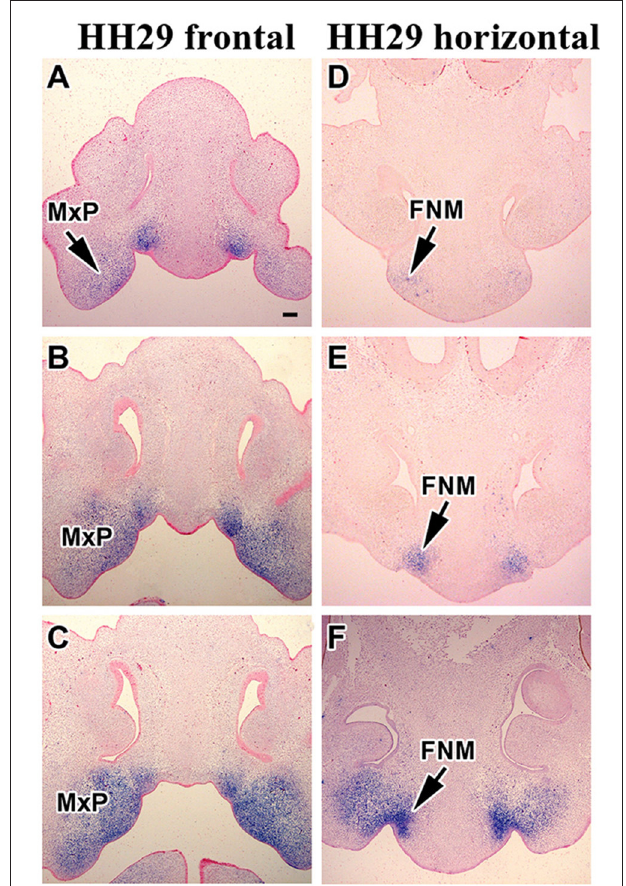
FIGURE 4 | MORN5 expression in the fusion region at stage 29. (A–C) Frontal sections of chicken head showed strong expression in the maxilla and in the area where edges of the maxillary prominences grow together with medial nasal prominence. (D–F) Horizontal sections of chicken head. (E) Region of fusion had prominent MORN5 expression. (F) More caudal section (other sample). Scale bars = 100 µ